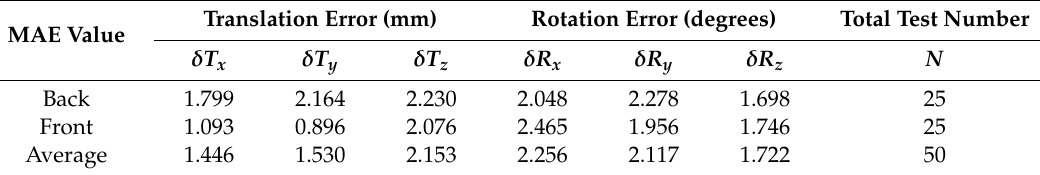
Table 6. Mean absolute error (MAE) measure for both front and back sides.